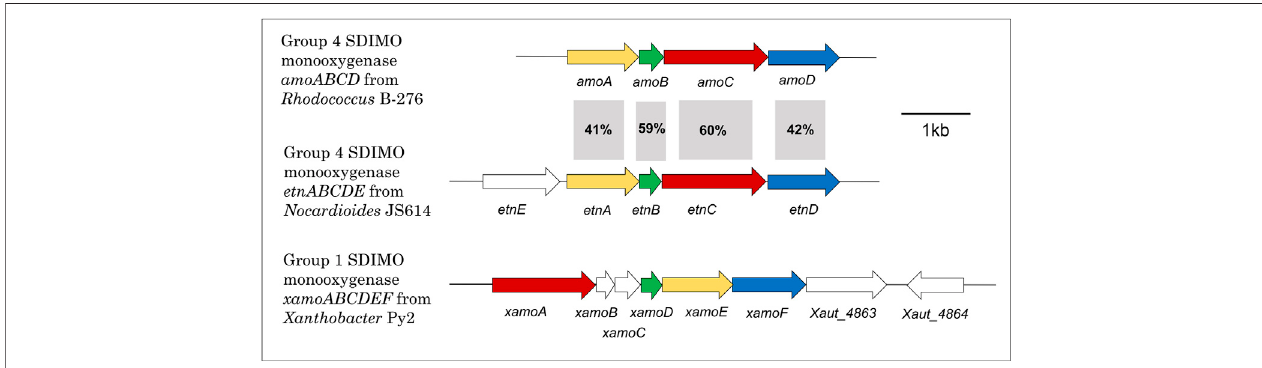
FIGURE 3 | Alkene monooxygenase gene cluster con fi gurations in Xanthobacter Py2, Rhodococcus B-276 and Nocardioides JS614. Colours indicate type of gene in monooxygenase to aid with comparison between clusters. Yellow (cid:1) beta subunit; green (cid:1) coupling protein; red (cid:1) alpha subunit; blue (cid:1) rubredoxin; white fi ll (cid:1) all other genes. % identity also